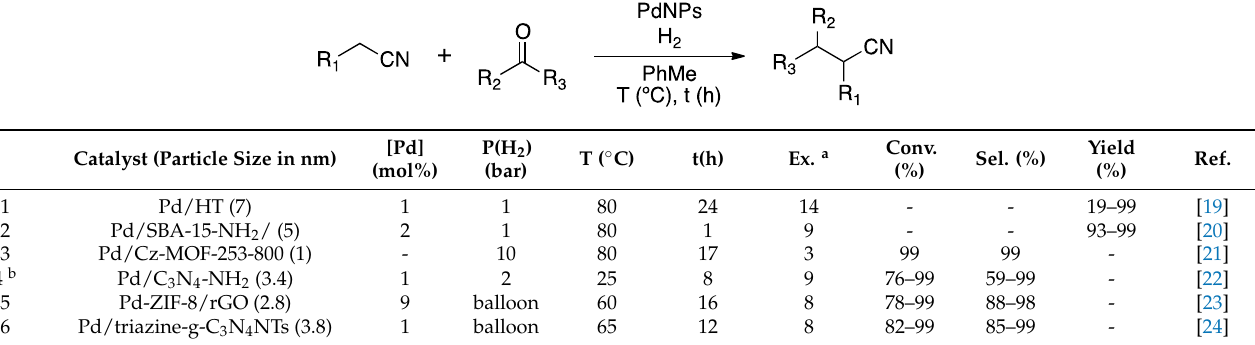
Figure 2. TEM images of the PdNPs on triazine-based-g-C 3 N 4 nanotubes (( a ) and ( b )). Inset in ( b ) shows crystallographic planes of fcc Pd(0) [24]. Reproduced from [24] with permission from Else- vier. Table 1. Comparison of the reported catalytic activity to the sequential condensation/reduction synthesis of α -alkylated nitriles.